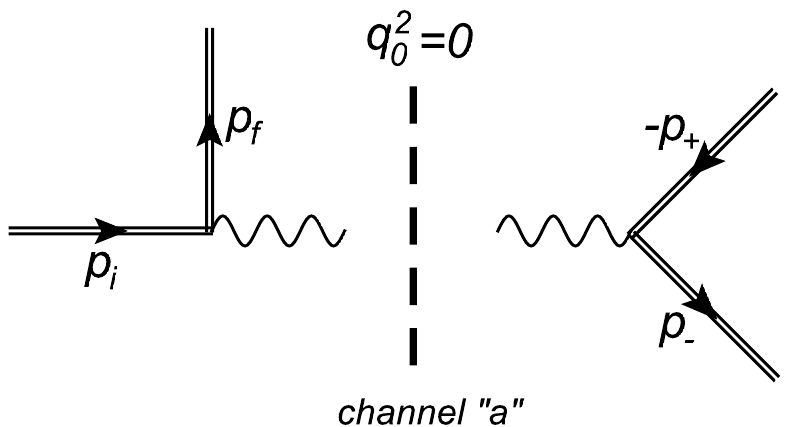
Figure 2. Feynman diagram of resonant electron-positron pair production by an electron in the field of an X-ray pulsar for channel “a”. It is shown that under the resonance condition, the process is effectively reduced into two successive processes: X-ray-stimulated Compton effect and X-ray-stimulated Breit–Wheeler